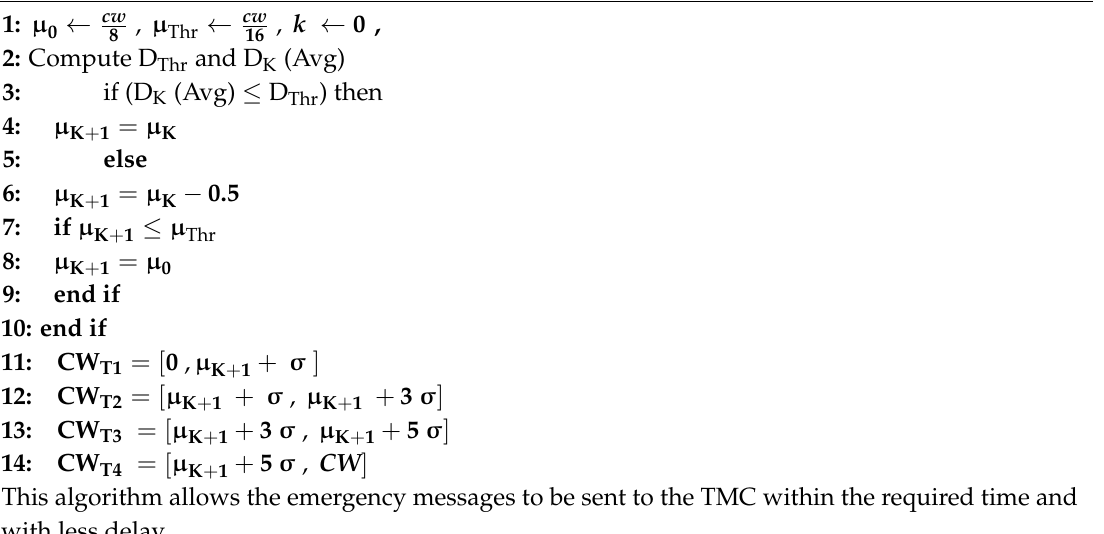
Algorithm 1. Priority for Emergency Traffic based MAC